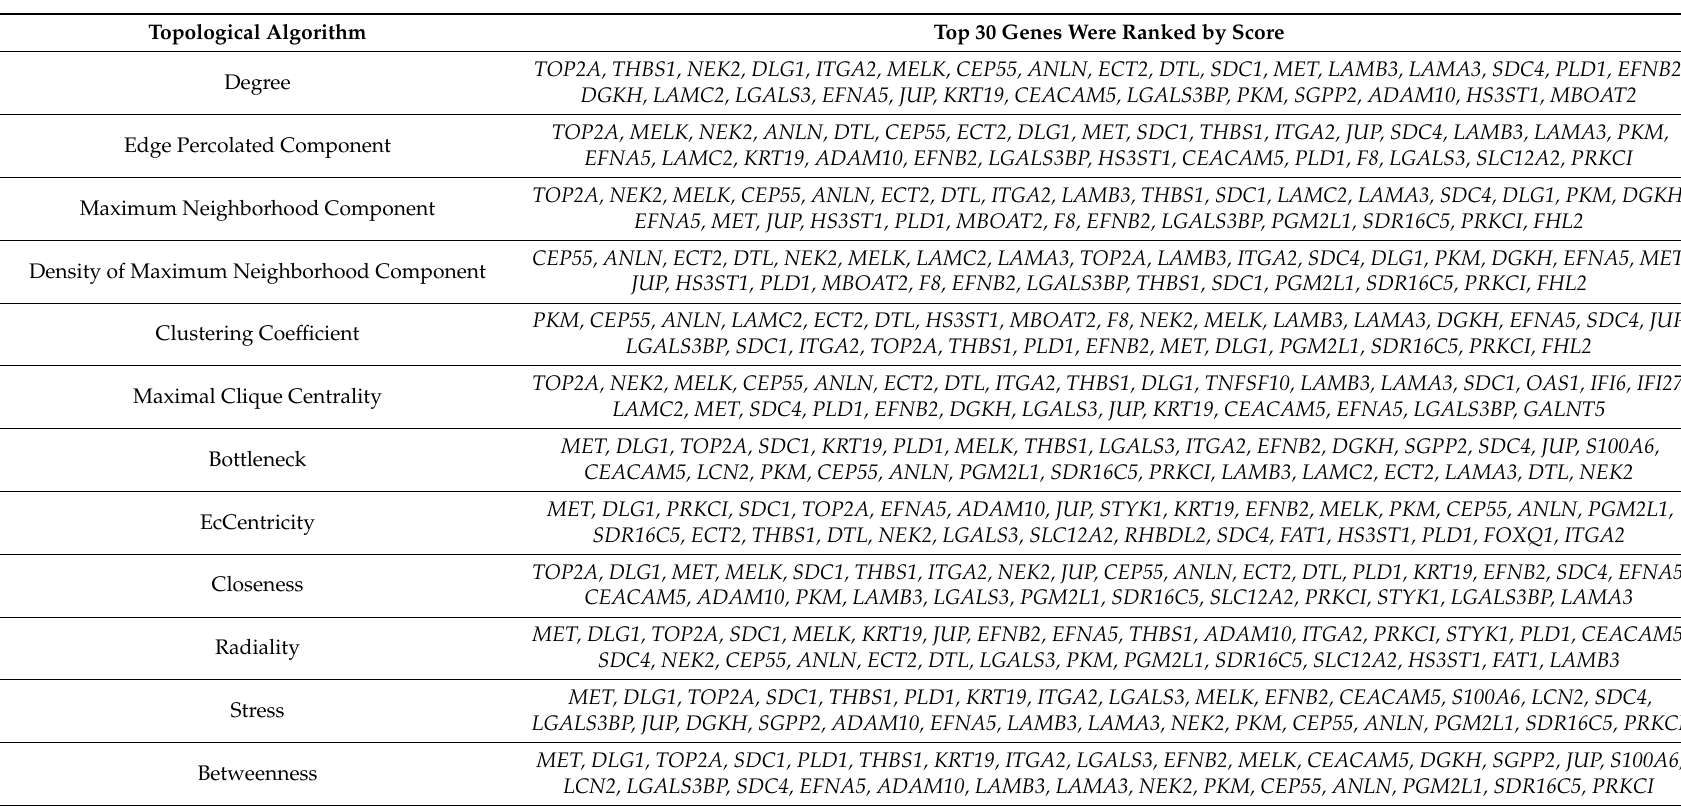
Table 2. The hub genes were analyzed by di ff erent topological algorithms in the protein–protein interaction network. Topological